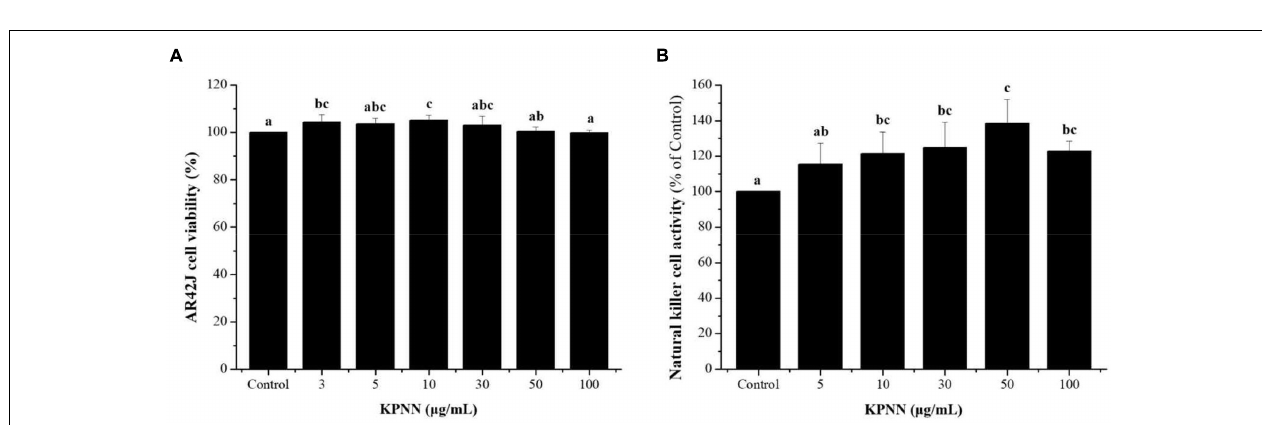
FIGURE 4 | Effects of KPNN on NK cell activity in the splenocytes. (A) Splenocytes were co-cultured with target cells (AR42J) in 96-well plates, followed by treatment with KPNN (0, 3, 5, 10, 30, 50, and 100 µ g/ml), and incubated for 24 h in a 5% CO 2 incubator with an effector to target cell ratio of 20:1. (B) NK cell activity was calculated as the survival rate of AR42J cells compared to that of the control. Bars labeled with different superscripts indicate significantly different values ( p < 0.05 vs. control). Data are presented as mean ± SEM ( n = 3).